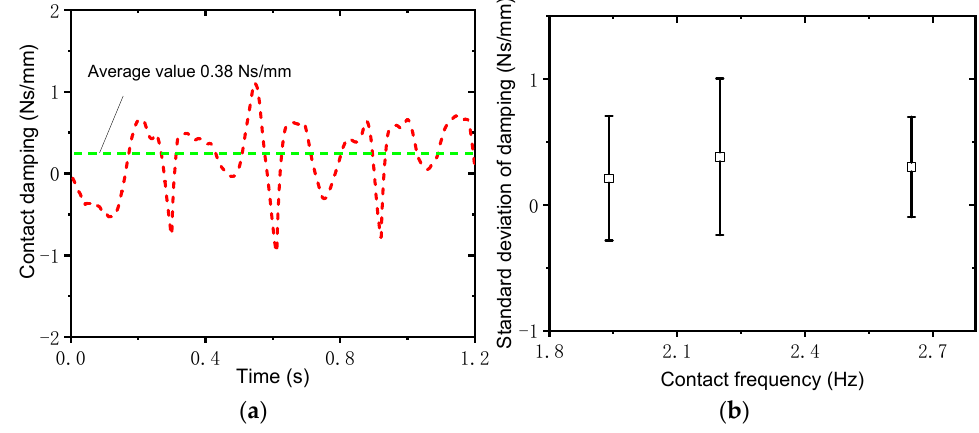
Figure 13. Estimates of stiffness in real collisions ( f = 2.2 Hz). ( a ) Identified results. ( b ) Standard deviation.